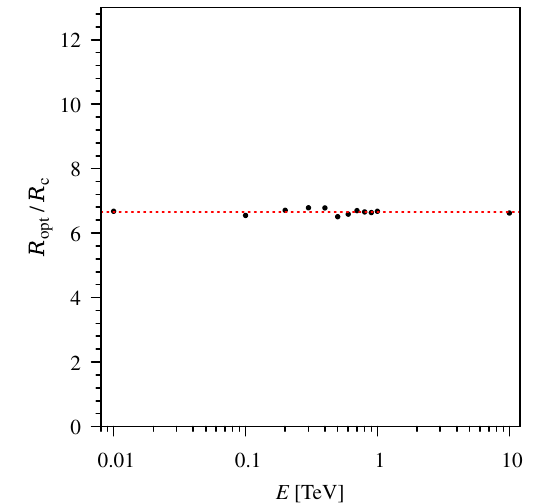
Fig. 5 The dependence of the ratio of the optimal radius of curvature to the critical radius of planar channeling on the particle energy for f = 0 . 1